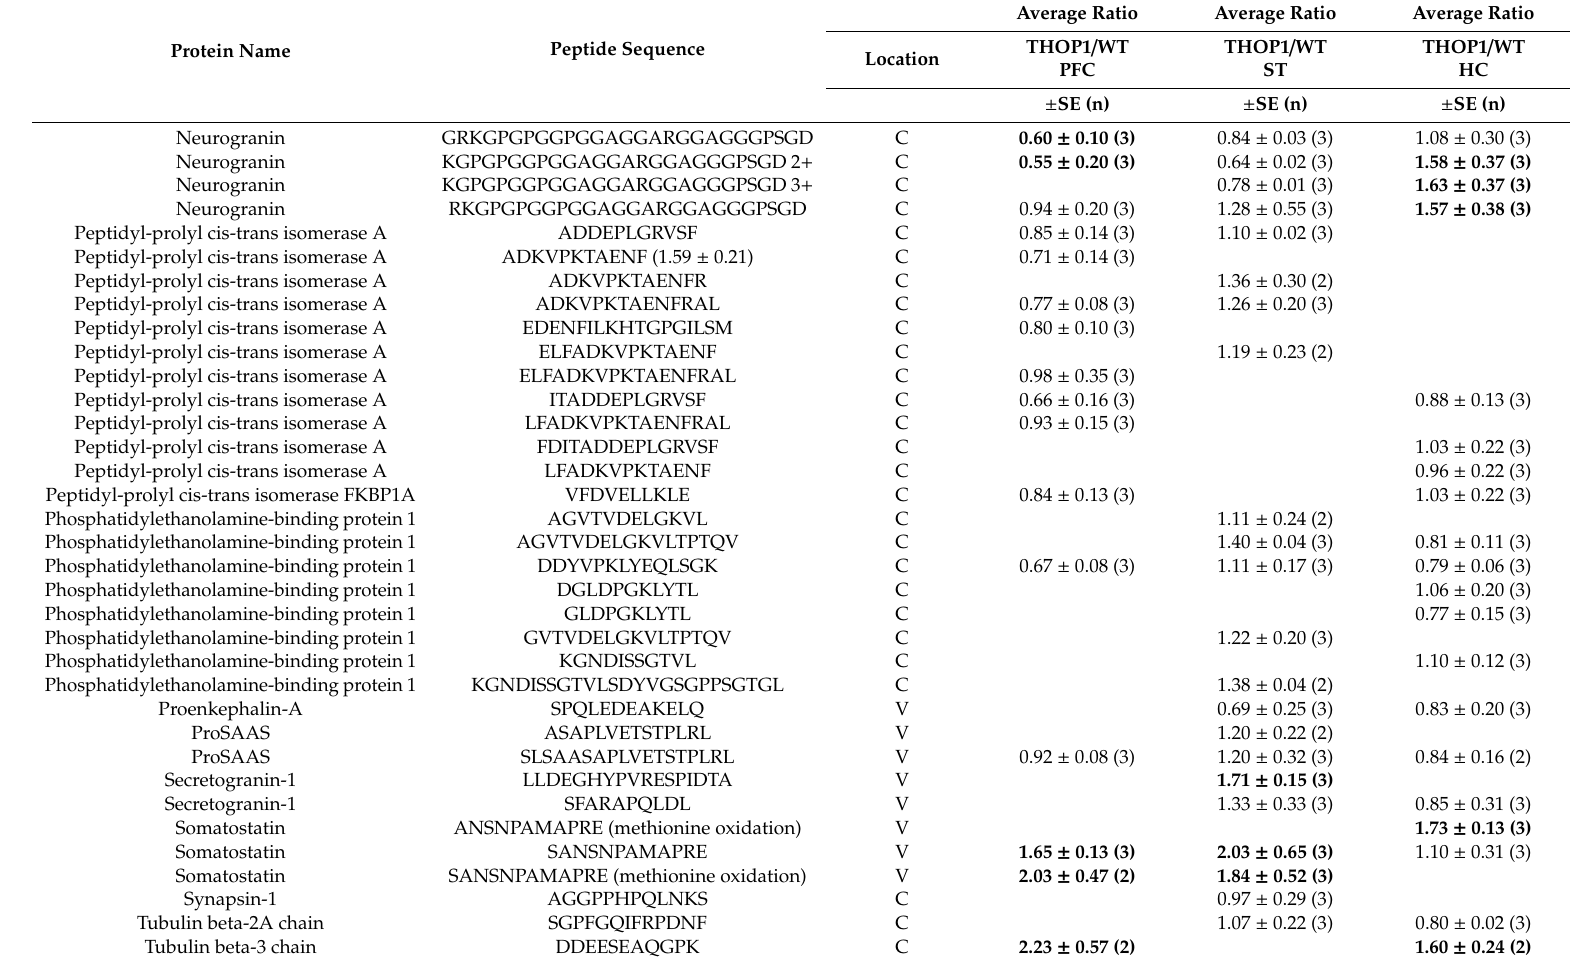
Peptides shaded in gray were previously found in Nln knockout mice (NLN - / - ); the number in parenthesis indicate the relative levels of the peptide in whole brain extracts from NLN - / - compared to WT mice [54]. C. cytosol; M. mitochondria; N. nucleus; V. vesicles. Numbers in bold indicate changes (bigger than 1.5 or smaller than 0.5) in relative peptides level from WT and THOP1 − / −